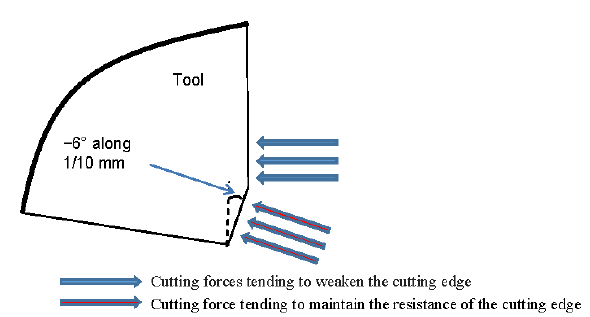
Figure 18. Orientation of machining efforts on a tool